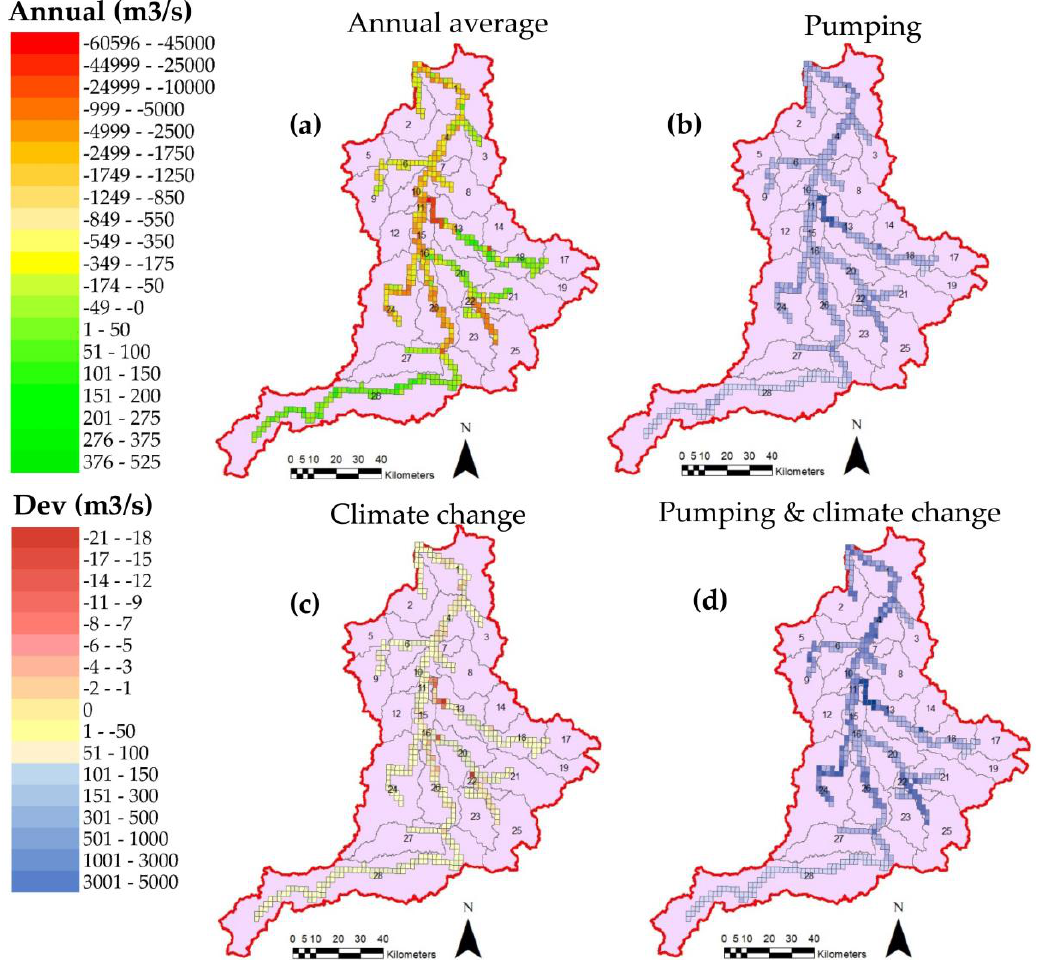
Figure 9. Long-term (1986–2007) average annual GW–SW exchange data ( a ), and differences from the average annual data for each MODFLOW river cell, with a pumping rate of 468 m 3 /d ( b ), the averaged RCP8.5 (the heaviest greenhouse gas emission) scenario for 2010–2034 ( c ), and the averaged RCP8.5 scenario with a pumping rate of 4680 m 3 /d ( d ). Dev (m 3 /d) = monthly (m 3 /d) − yearly (m 3 /d).